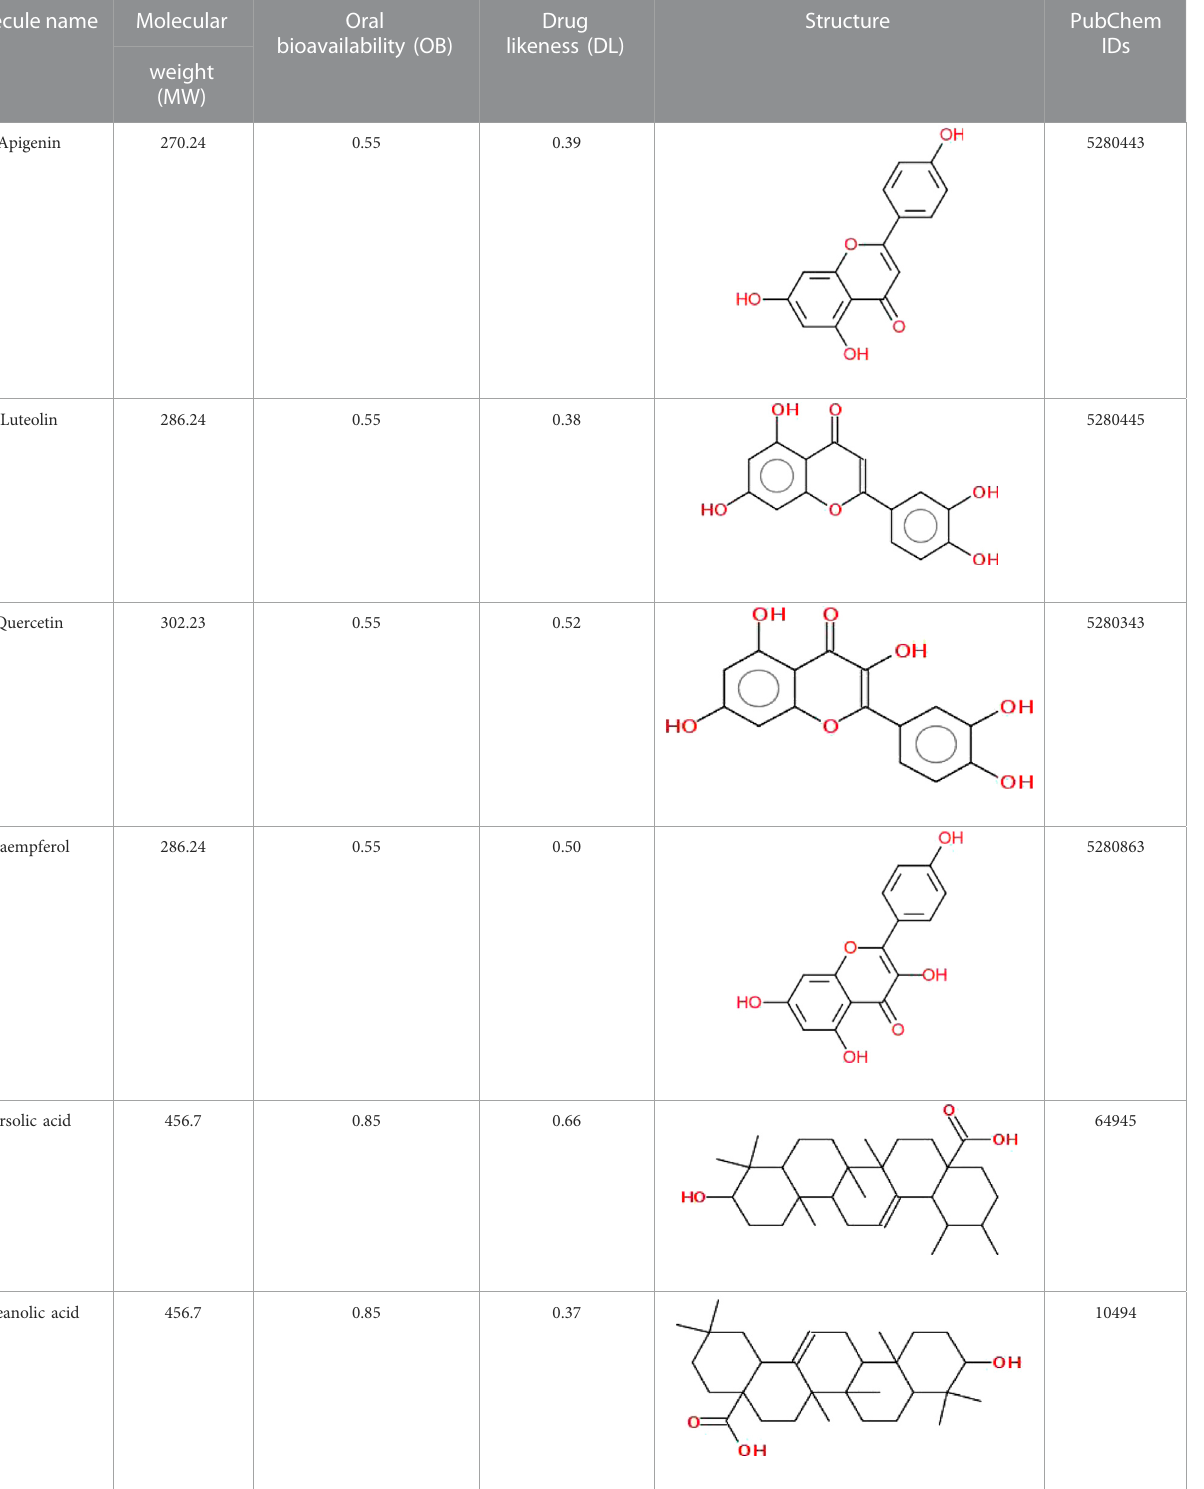
TABLE 1 Physiochemical properties, 2D structure, and PubChem IDs of fi nal